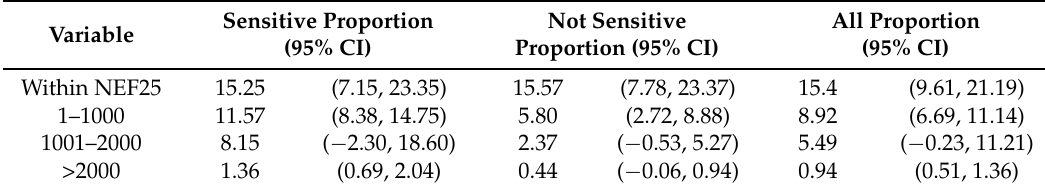
Table A7. Distance to the NEF25 contour and marginal proportions of sleep disturbance by airplanes in the weighted study sample adjusted for sensitivity to noise: marginal prediction by sensitivity.